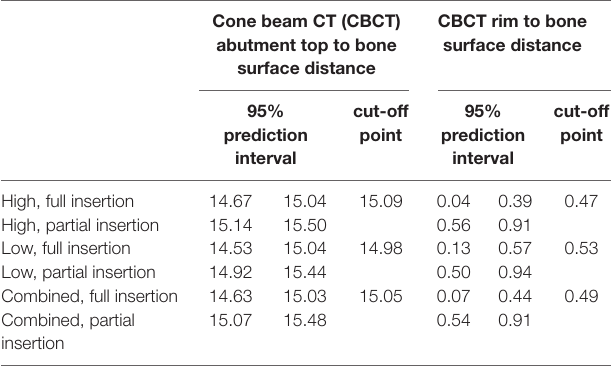
TABle 1 | Prediction intervals and cutoff points.